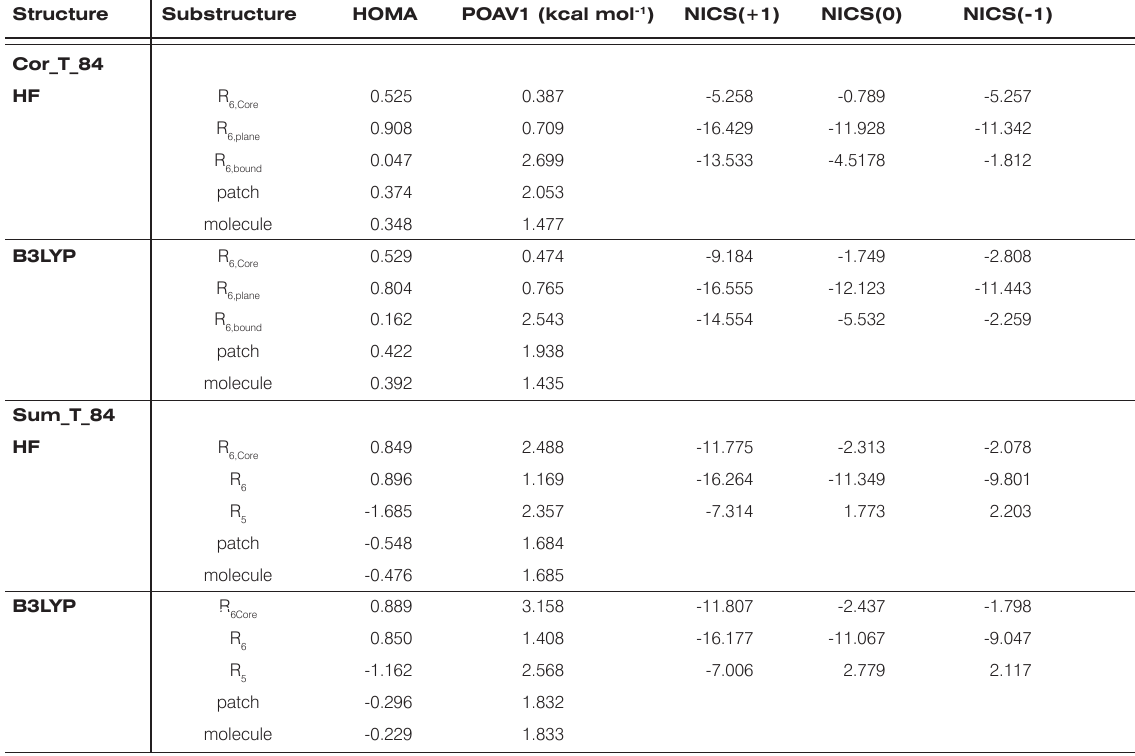
Table 8. Aromaticities (in terms of the HOMA and NICS indices) of the coronene and sumanene patches in the tetrahedrally spanned fullerenes, optimized at HF/6-31G(d,p) and B3LYP/ 6-31(d,p) levels of theory, respectively. Structure